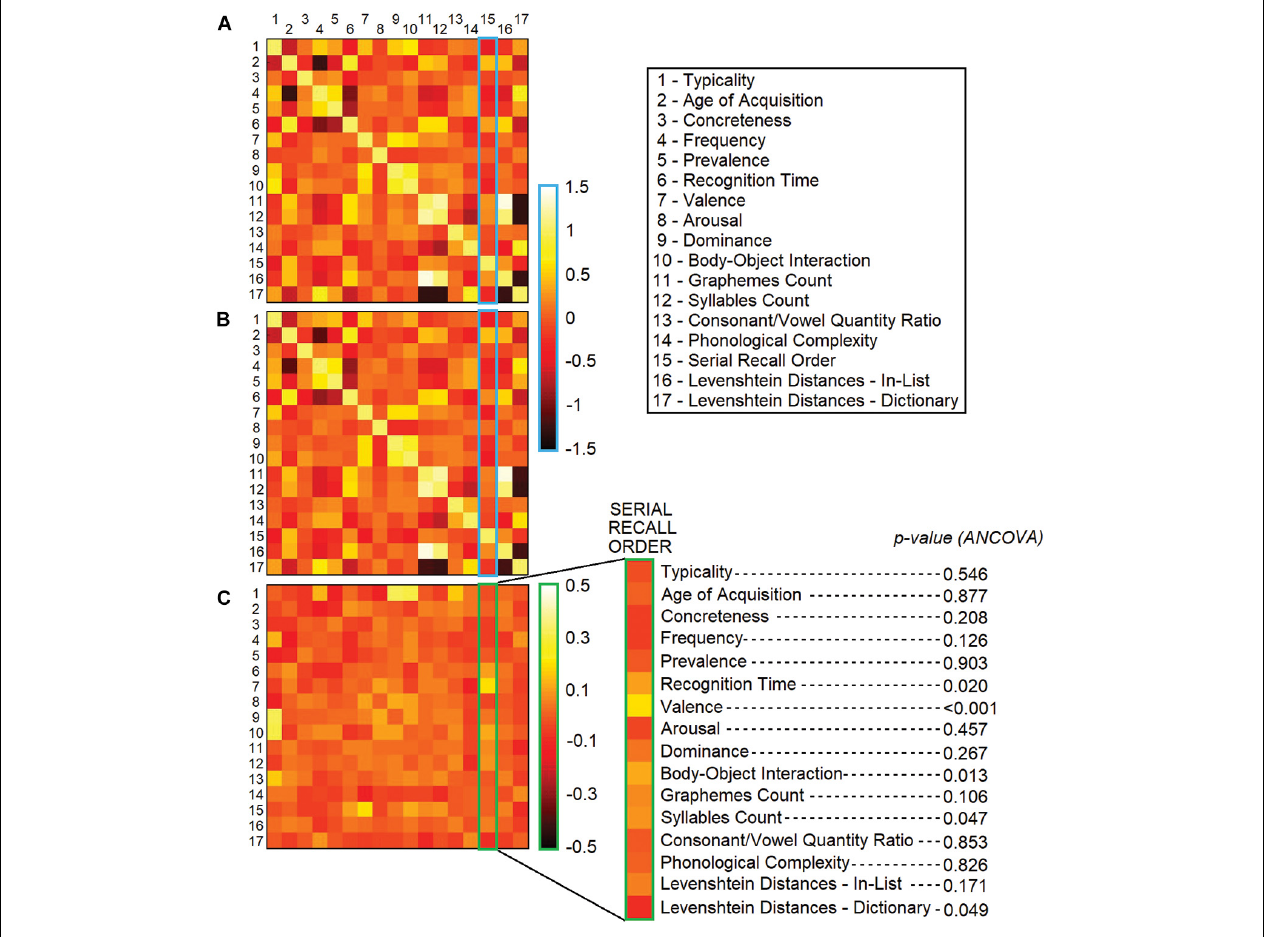
FIGURE 3 | z -transformed coefficients of correlation calculated across the entire 17 × 17 matrix within the group of older adults (A) and younger adults (B) . Between-group difference scores (where scores among older and younger adults are the subtrahend and minuend, respectively) are shown below (C) , flanked by the outcome of statistical comparisons. Blue and green frames were added to highlight the coefficients of correlation relevant to this